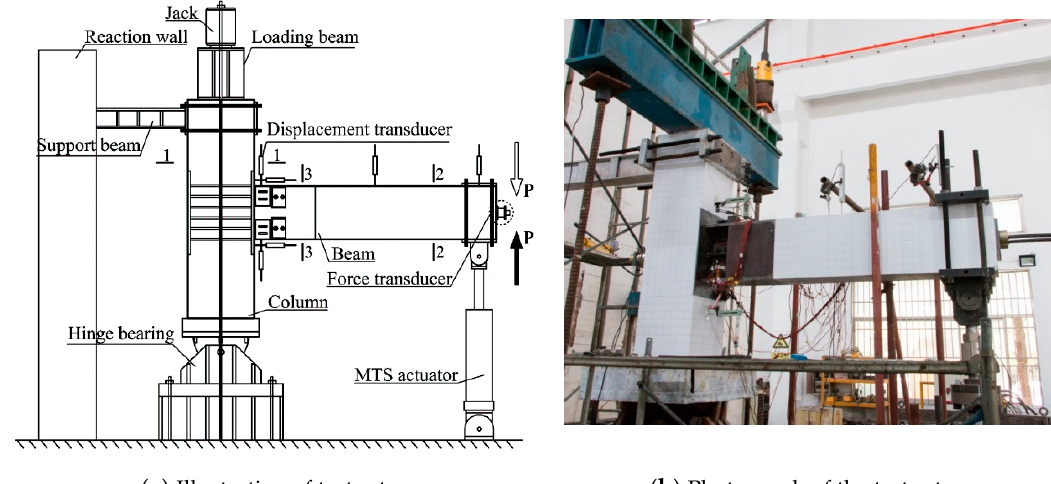
Figure 4. Cyclic loading test set up.